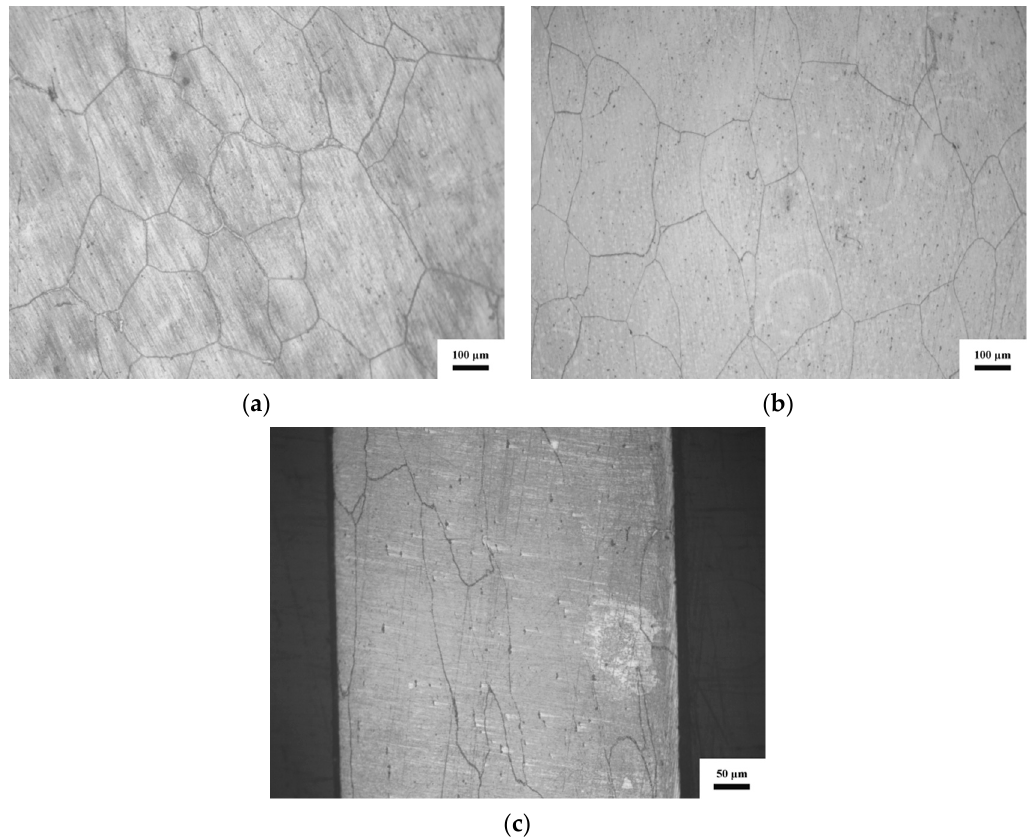
Figure 3. Optical micrographs of deformed samples under different strain rates: ( a ) 1250 s − 1 ; ( b ) 2000 s − 1 ; ( c ) 4800 s − 1 .